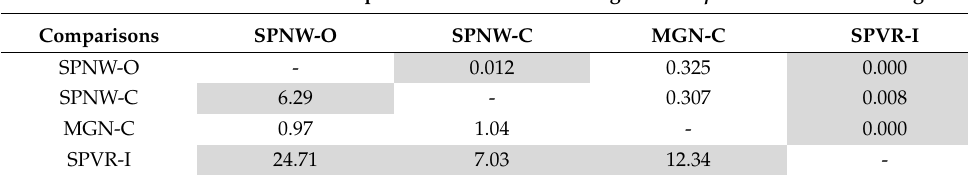
Pearson’s Chi-Square Values below the Diagonal and p Values above the